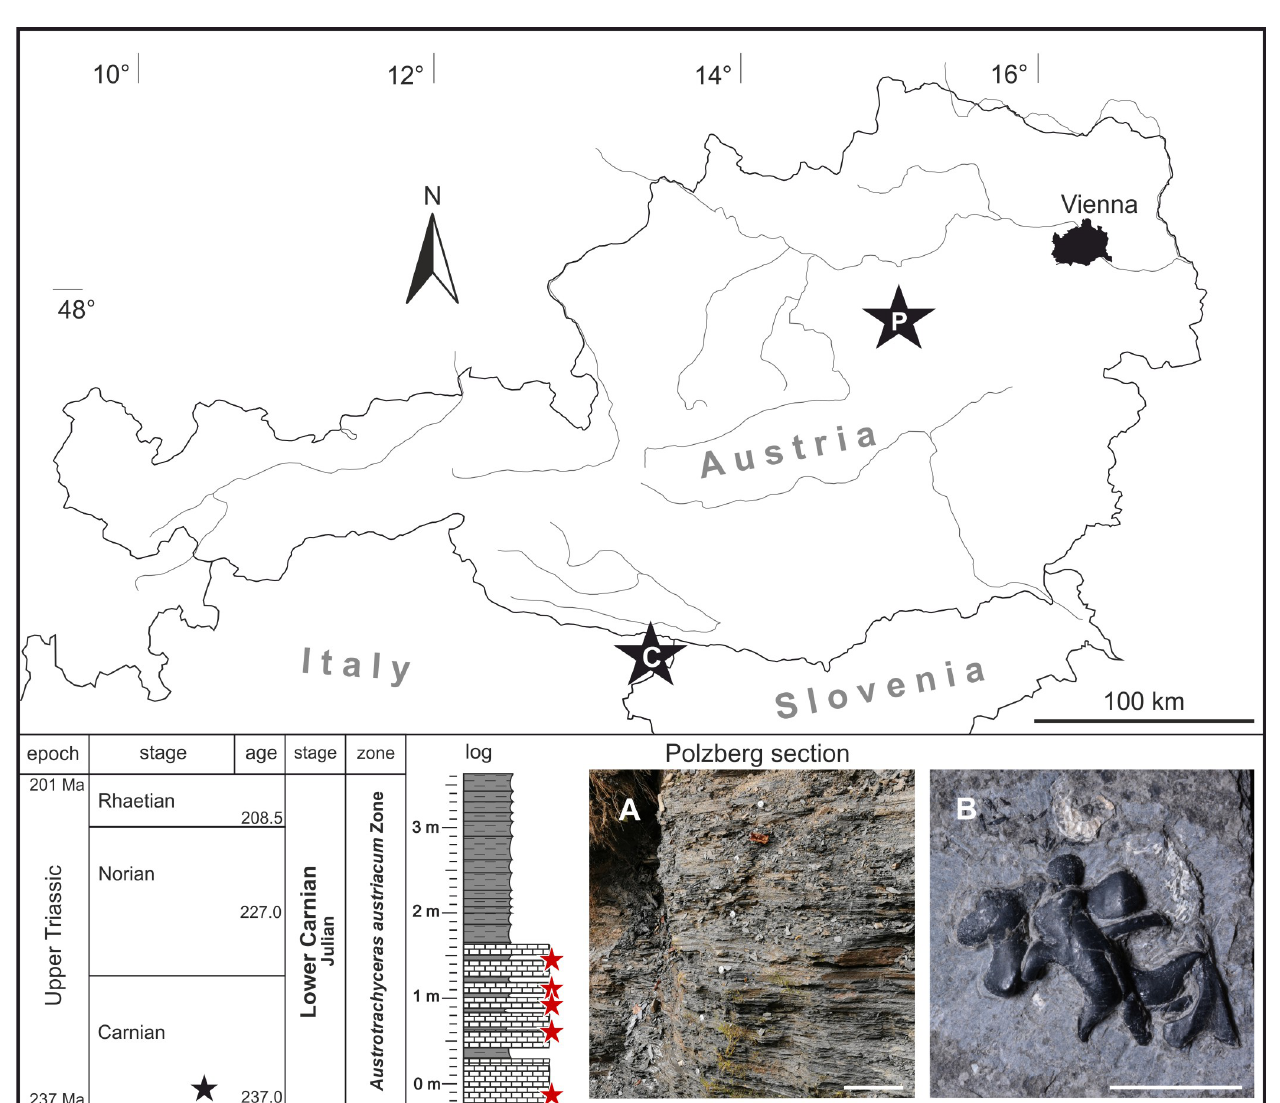
Fig 1. Austrian map with stratigraphic and lithological overview and positions of layers (red asterisks) comprising the here described black carbonized fossils. Black asterisk with P: position of the Konservat-Lagerstätte Polzberg (= Schindelberggraben ravine, Polzberg locality) near Lunz am See. Black asterisk with C: Cave del Predil, Italy comprising also deposits with enigmatic black fossils. (A) Vertical section (middle part) of Polzberg locality. Black asterisk marks position within the stratigraphic scale. Scale bar 20 cm. (B) Enigmatic carbonized structure from Polzberg locality, NHMW 2021/0001/0002. Scale bar 1 cm.